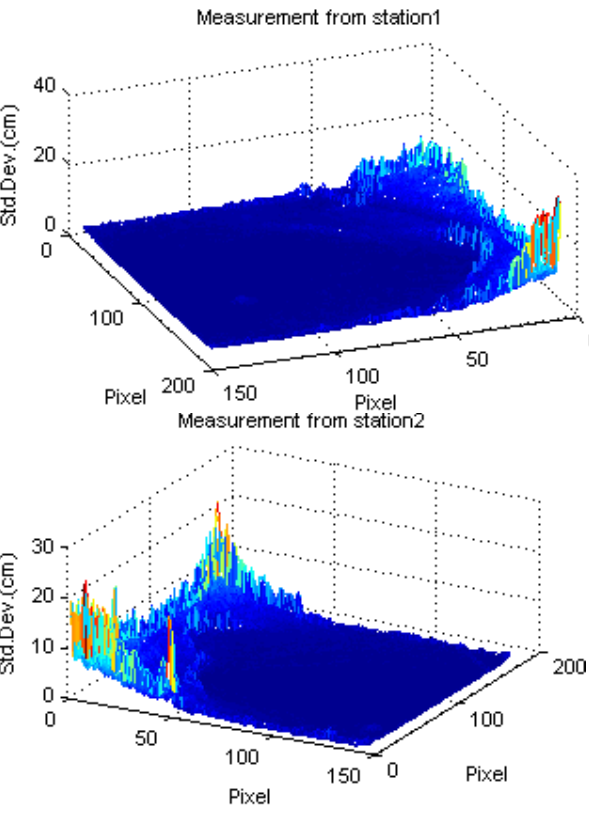
Figure 3. Standard deviations of the average measurements from two station